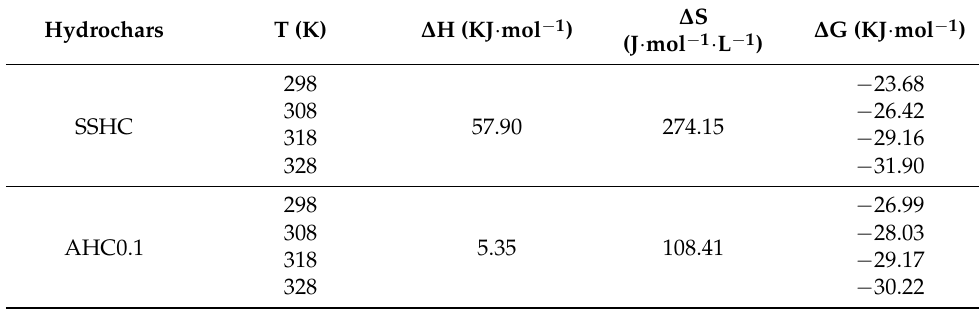
Table 8. Parameters of adsorption thermodynamics.